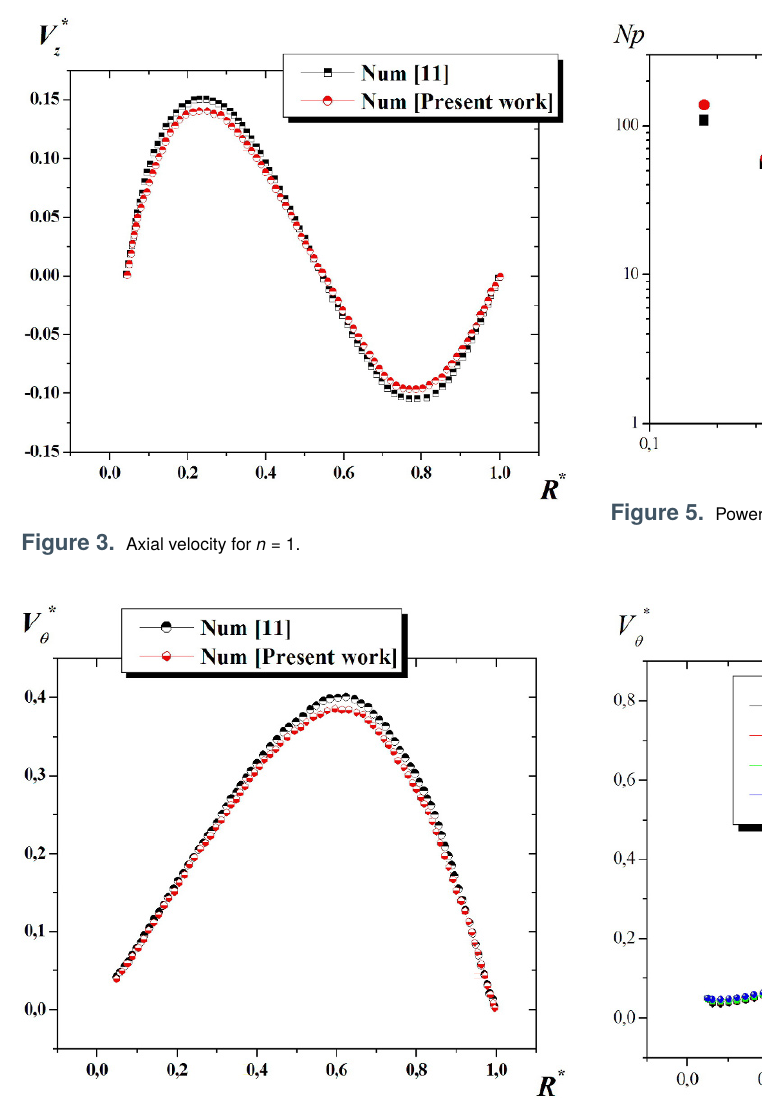
Figure 6. Tangential velocity for double helical ribbon impeller, at Re g = 60 , Z ∗ = 0 . 48 , θ = 0 0